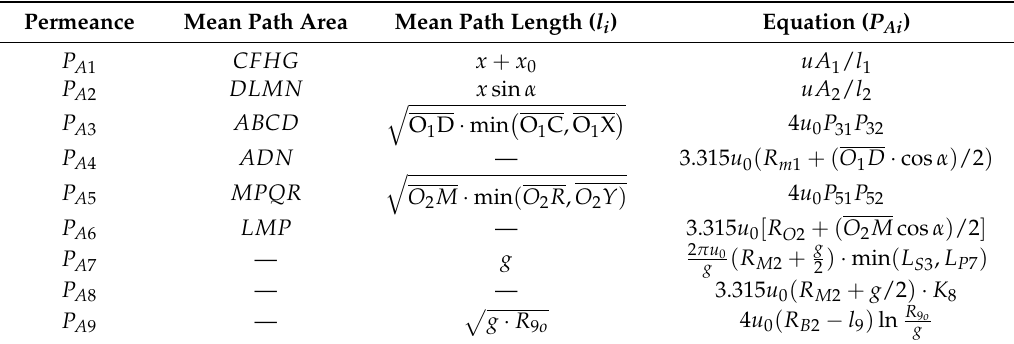
Table 2. Permeance of air gaps in the proportional